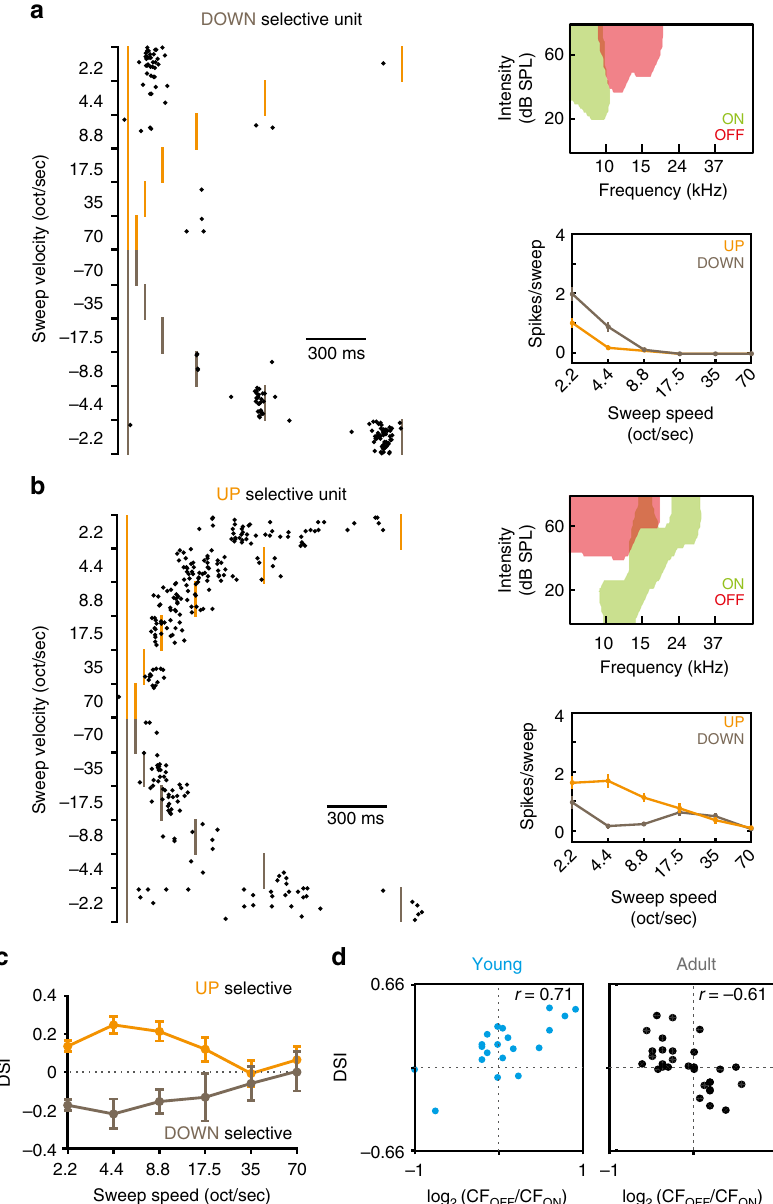
Fig. 5 Arrangement of ON and OFF receptive fi elds confers direction selectivity to slow frequency-modulated sweeps in vivo. a Response of a DOWN- selective unit to 3-octave FM sweeps. Left, raster plot of spiking responses to different velocities. Orange and brown ticks indicate beginning and end of UP and DOWN sweeps, respectively. Top right, outline ON and OFF FRAs for the same unit. Bottom right, mean spiking responses to sweeps at different speeds for UP and DOWN directions. b Same as a , but for an UP-selective unit. c Direction selectivity index (DSI) at different speeds for the UP-selective units (orange) and DOWN-selective units (brown) recorded in adult A1. Positive DSI indicates selectivity for UP FM sweeps. Only units with measureable ON and OFF receptive fi elds were included. In these units, direction selectivity was observed at slower speeds only (>35 oct/sec). d Relationship between directional selectivity and ON/OFF receptive fi eld organisation in young (left) and adult (right) A1 neurons. Octave spacing between ON and OFF CF is indicated on the bottom axis. Positive values indicate that OFF CF is higher than ON. Each point represents an individual unit (adult: n = 30; young: n = 20). DSI values represented are calculated at the lowest speed (2.2 oct/sec). In adult A1, directional selectivity and ON/OFF receptive fi eld arrangement correspond as predicted in